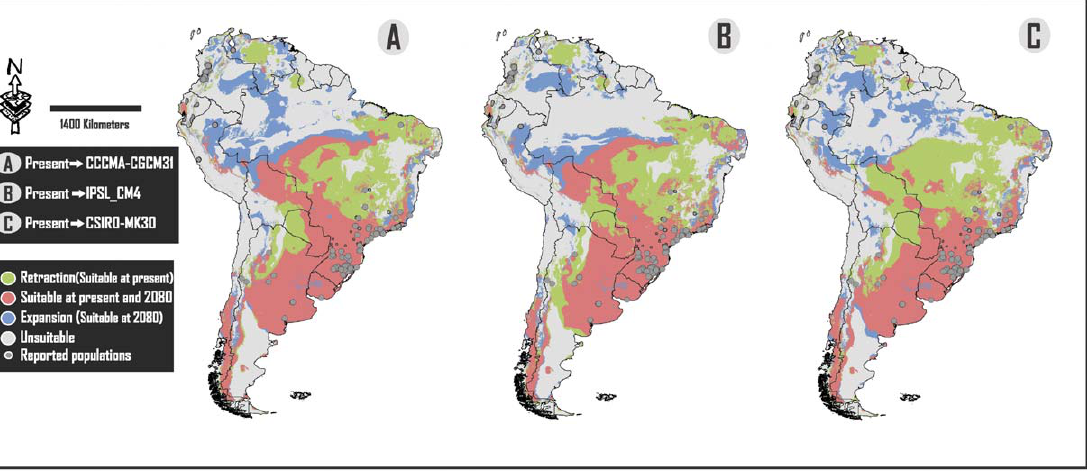
Figure 1. Comparison between results of projections at present and 2080. Each map shows potential suitable areas for Lithobates catesbeianus at one of the three different analyzed AOGCMs, classified in: Retraction (suitable areas at present but not at 2080), Expansion (suitable areas at 2080 but not at present conditions) and suitable areas at present and at 2080.